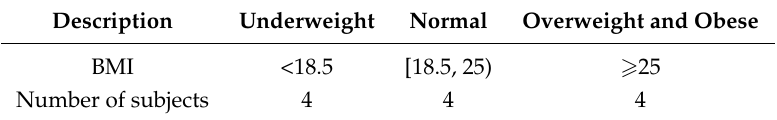
Table 4. Body Mass Index (BMI) distribution of the subjects participating in the experiments Description